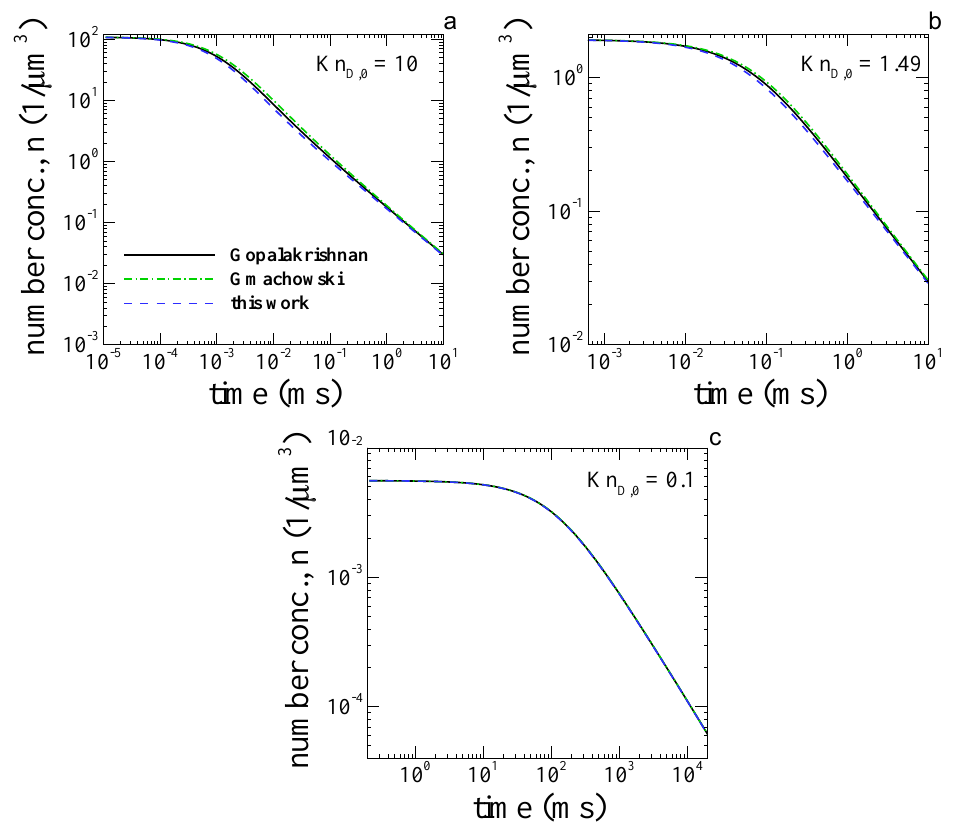
Figure 6. The figures ( a – c ) represent the particle number concentration as a function of time. The proposed method (blue dash line) is compared with [12] (black continuous line) and the harmonic mean method, equivalent to [14] (green dash-dotted